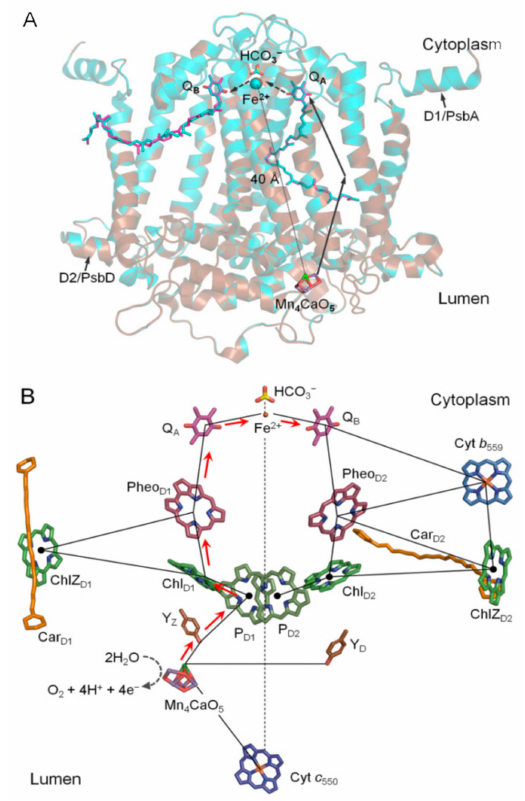
Figure 1. Electron transport pathway in the photosystem II complex. ( A ) Superimposed structures of the D1 / D2 proteins from the native (cyan; PDB: 3WU2) and Sr-modified oxygen-evolving complex (OEC) (brown; PDB: 4IL6) photosystem II. The figure highlights the donor (Mn 4 CaO 5 cluster) and the acceptor (Q A -Fe 2 + / HCO 3 − -Q B ) sites, which are about 40 Å apart. ( B ) The electron transfer (ET) pathway and the locations of the main cofactors involved in the electron transfer